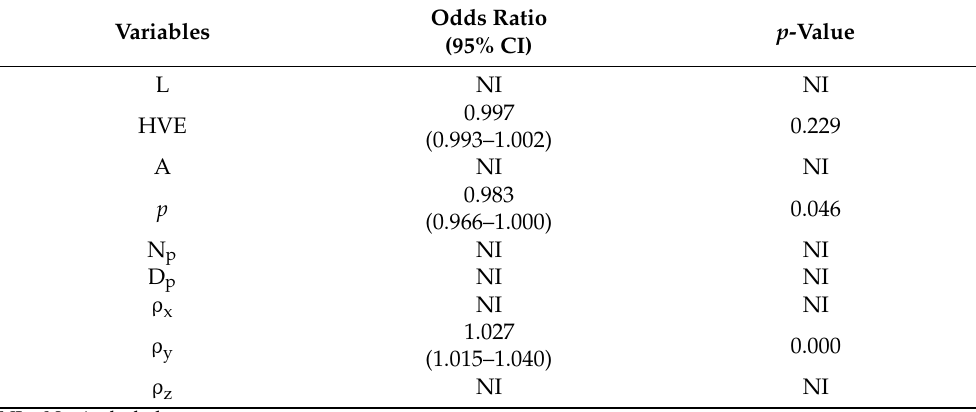
Table 3. The results—odds ratio with 95% confidence interval (CI) and p -values—of the multivariate logistic regression. Accuracy of MLR =